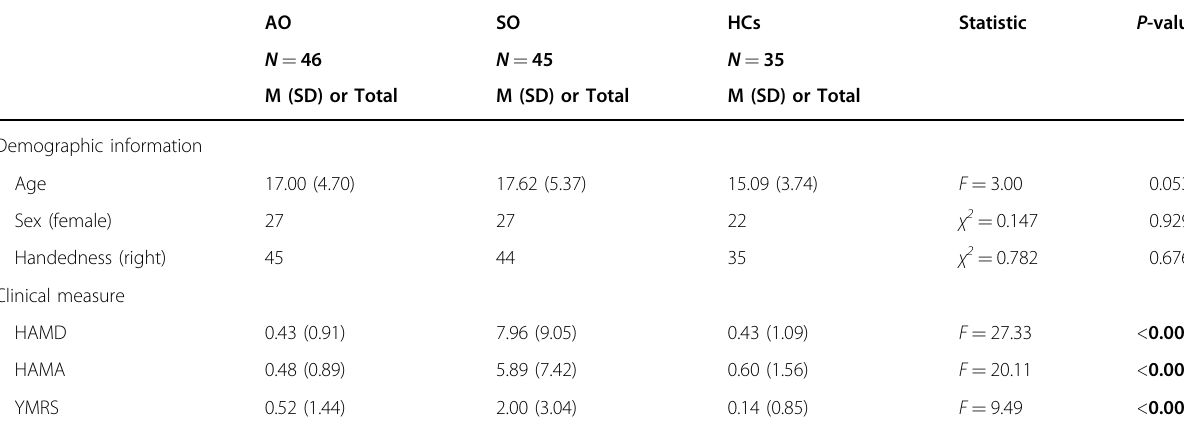
Table 1 Demographics and clinical characteristics among AO, SO, and HCs. AO